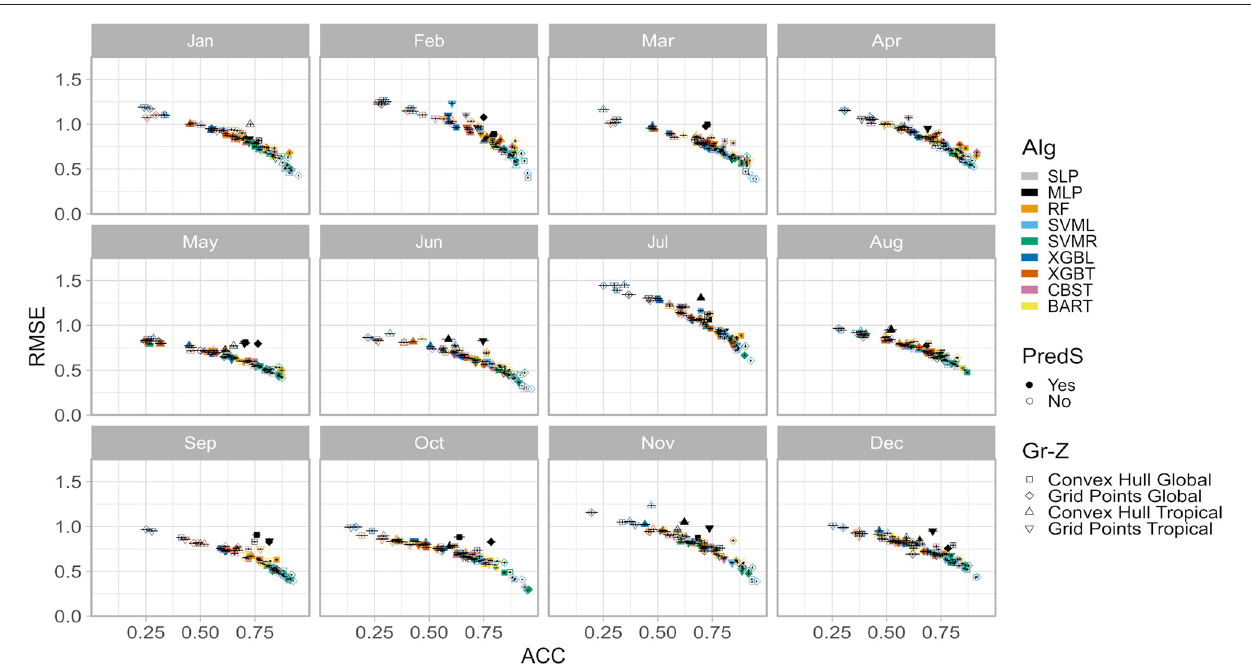
FIGURE 4 | Comparison of model performances during the training phase, in terms of anomaly correlation coefficient (ACC) and root mean square error (RMSE). Shapes correspond to the different combination geographical region/zone (Gr-Z). Colors are the ML algorithms (Alg) with a filling (contour) corresponding to the existence (absence) of feature selection. Vertical and horizontal segment are the dispersion of the performance across the samples.